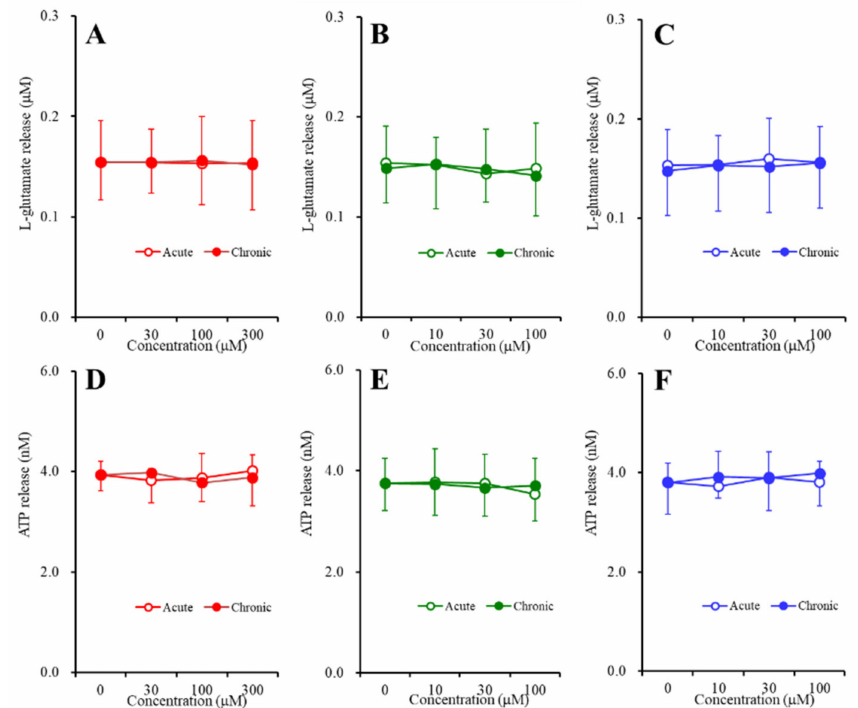
Figure 4. Concentration-dependent e ff ects of the acute (open circles) and subchronic (closed circles) administration of ( A , D ) zonisamide (ZNS) (30, 100, or 300 µ M), ( B , E ) carbamazepine (CBZ) (10, 30, or 100 µ M), and ( C , F ) lacosamide (LCM) (10, 30, or 100 µ M) on the basal astroglial release of ( A – C ) l -glutamate and ( D – F )ATP. Ordinate: mean ± SD ( n = 6) of the basal astroglial release of l -glutamate ( µ M) and ATP (nM). Abscissa: concentration of ZNS, CBZ, and LCM ( µ